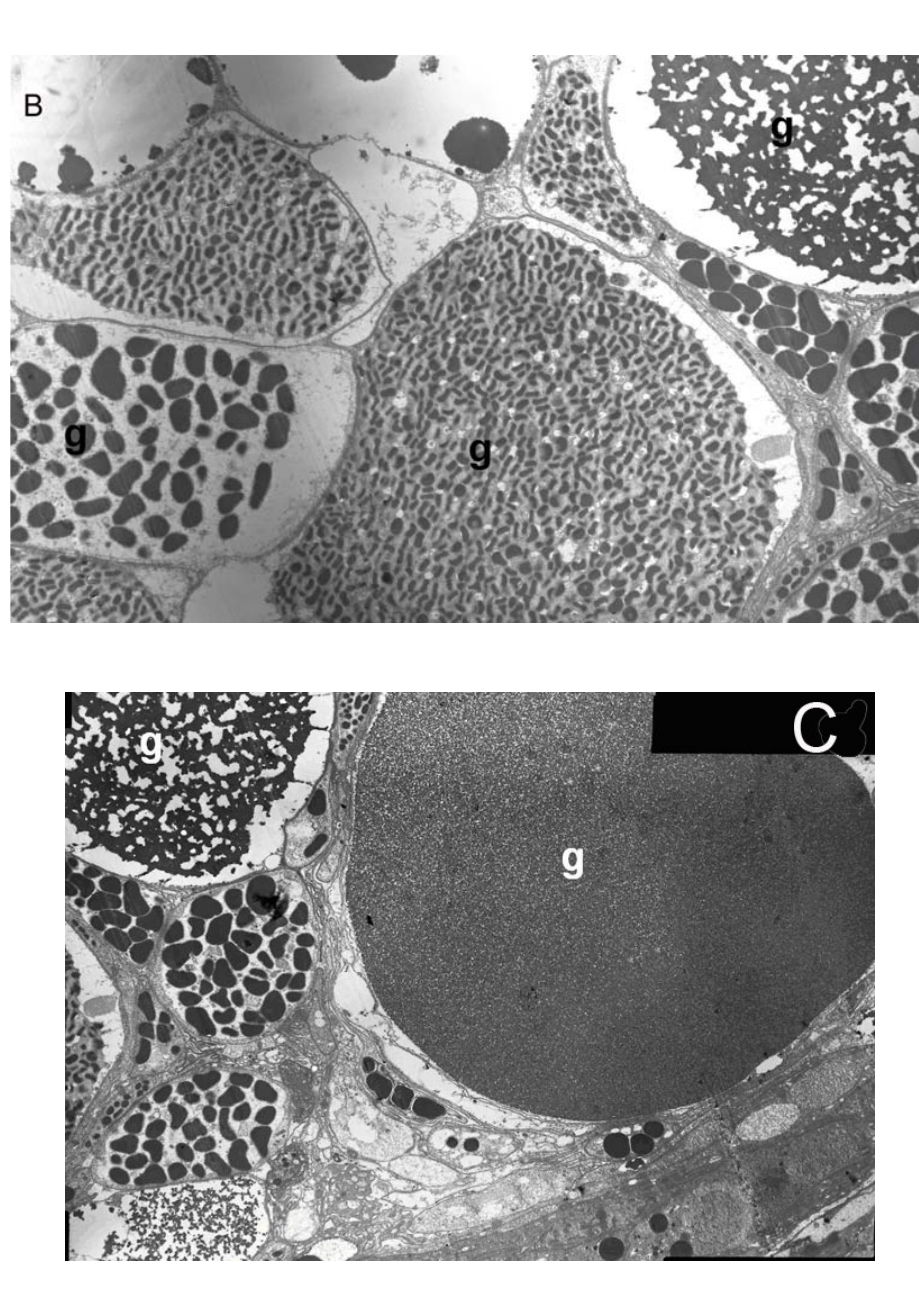
Figure 5. ( A ) Thick muscle layer, glandular epithelium, beginning of lumen, glandular epithelium made up of simple columnar secretory cells and their cytoplasm filled with many secretory granules of different sizes, shapes and densities under light microscope (397x). ( B , C ) The different granules (g) in secretory cells under TEM ( B : 3,040x; C :